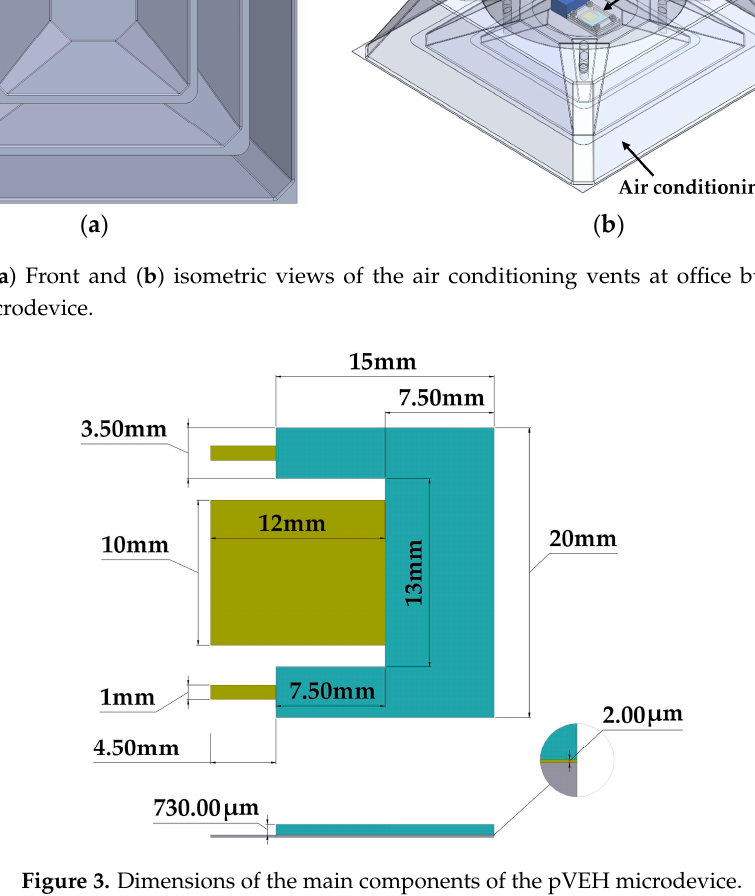
Figure 3. Dimensions of the main components of the pVEH microdevice.